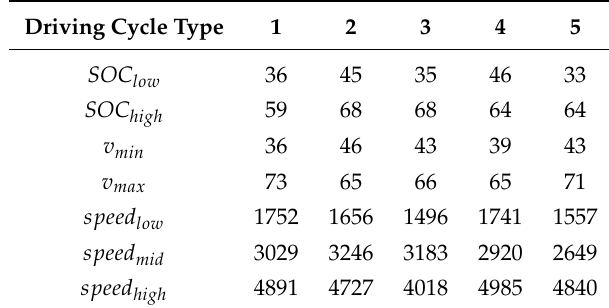
Table 9. Control parameter optimization results of five typical driving cycles.